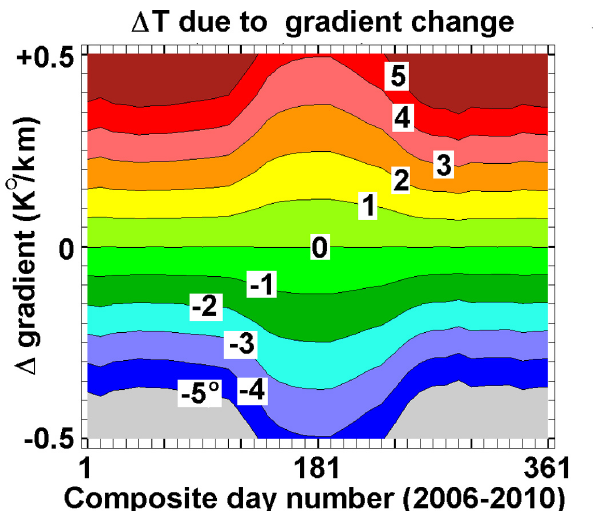
Fig. 1. Sensitivity of SKiYMET temperatures to change in empiri- cal temperature